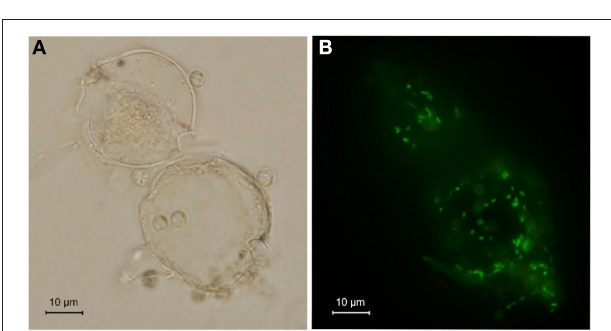
FIGURE 8 | Debris of A. tamarense attached with flagellate and bacteria. (A) Bright-field image. (B) Fluorescence image of bacteria after staining with SYBR Green